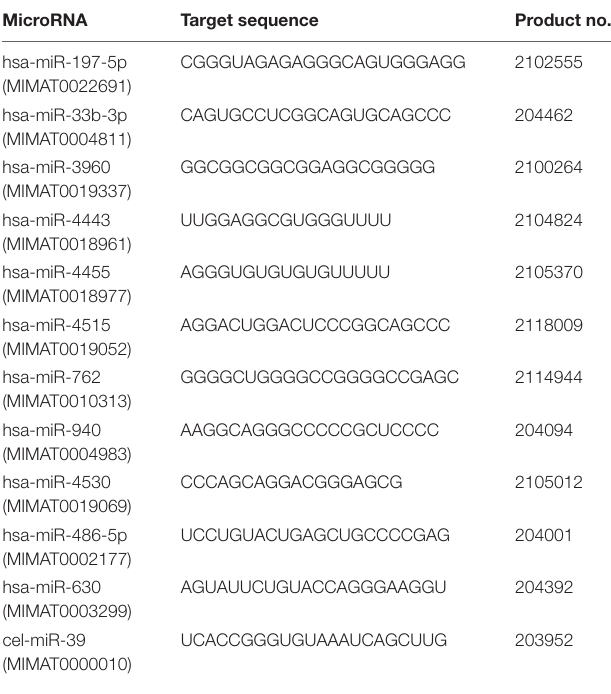
Microrna Target sequence Product